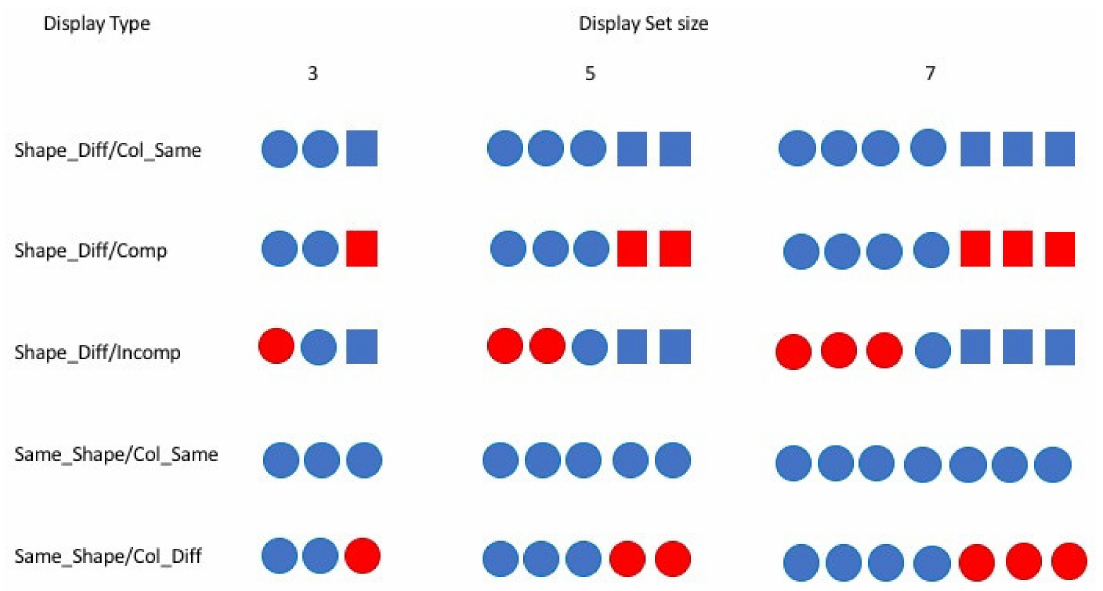
Figure 1. Examples of the composition of the displays used. The figure does not reflect the spatial layout of the shapes in the displays. The individual shapes were positioned randomly within a virtual rectangle centered at fixation and the positions of the shapes were determined at random prior to each trial. An important constraint was that none of the shapes could